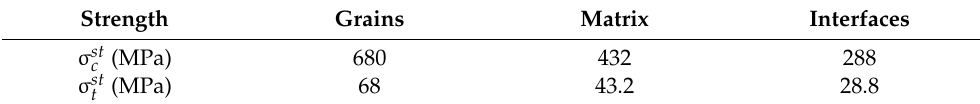
Table 4. Final strength